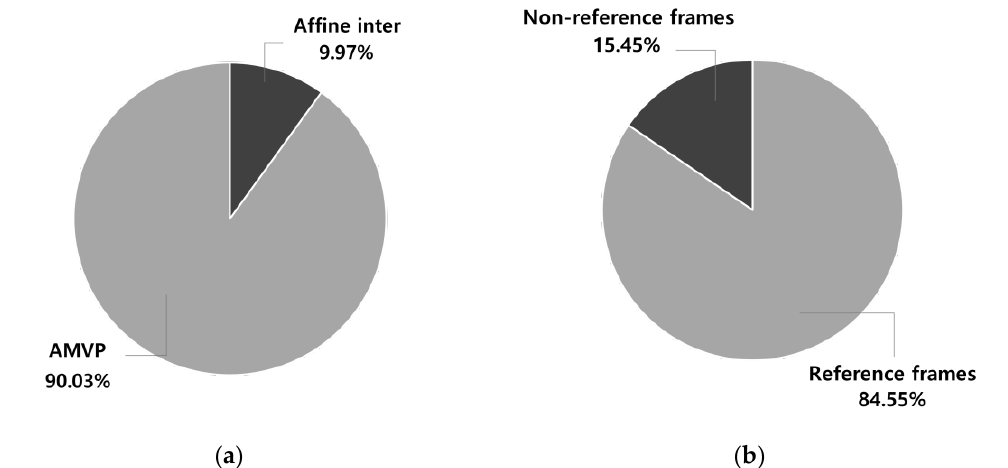
Figure 4. Analysis of affine inter mode in the random-access configuration of JVET CTC: ( a ) Distributions between affine inter mode and AMVP mode; ( b ) Distributions of affine inter mode on the reference and non-reference frames.